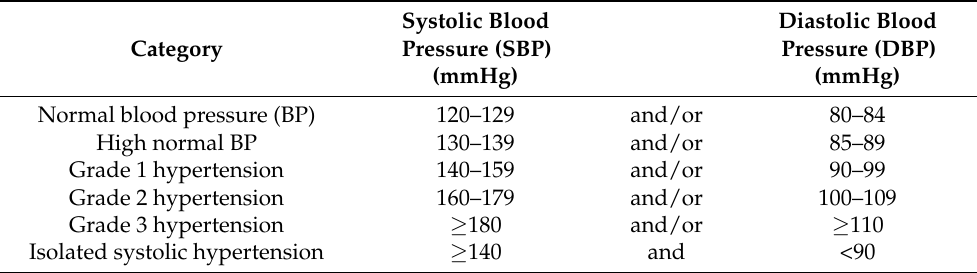
Table 2. The grades of